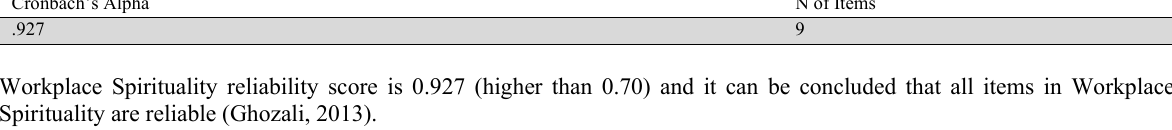
Workplace Spirituality Reliability Statistics Result Cronbach’s Alpha